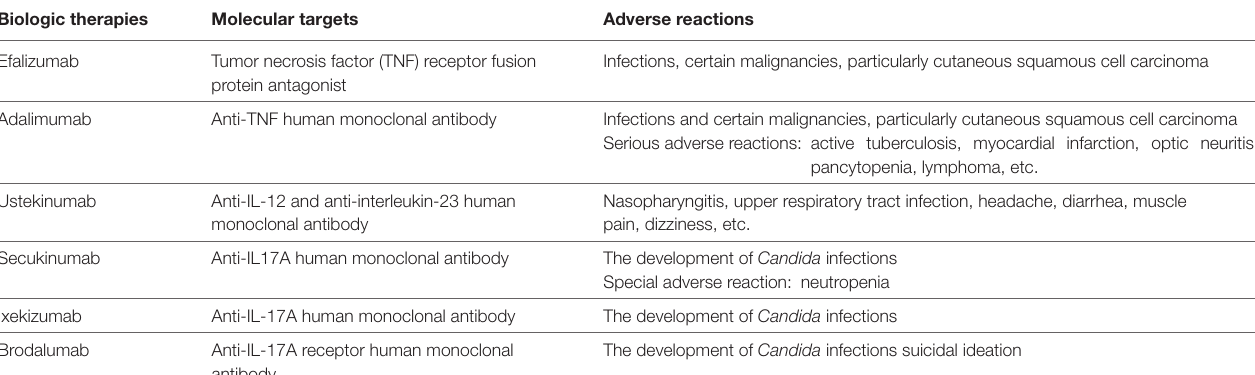
TAble 2 | Biologic therapies for